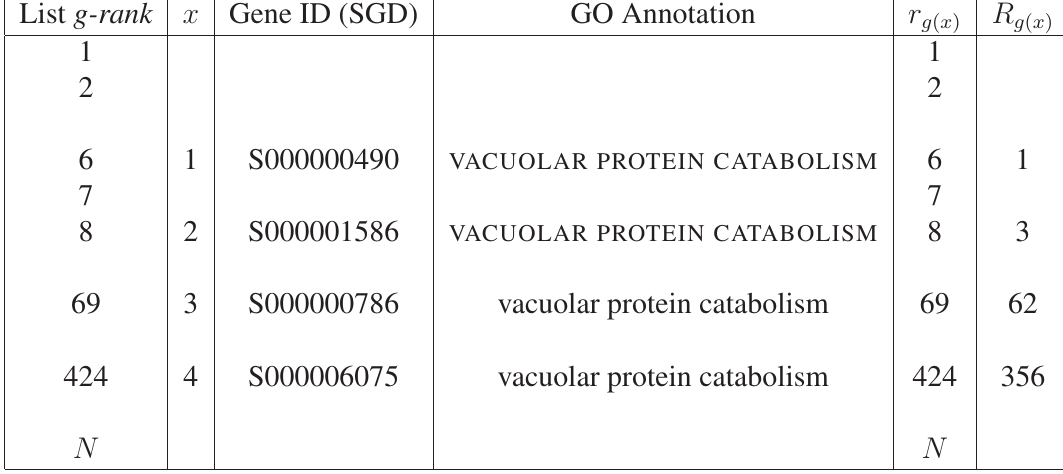
Table 1: CGGA Analysis for the FEG of genes annotated ”vacuolar protein catabolism”